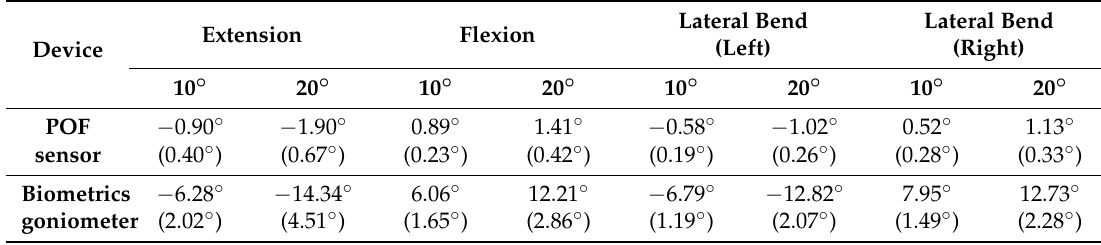
Table 1. Mean angles (standard deviation) of the lumbar region measured by the POF sensor